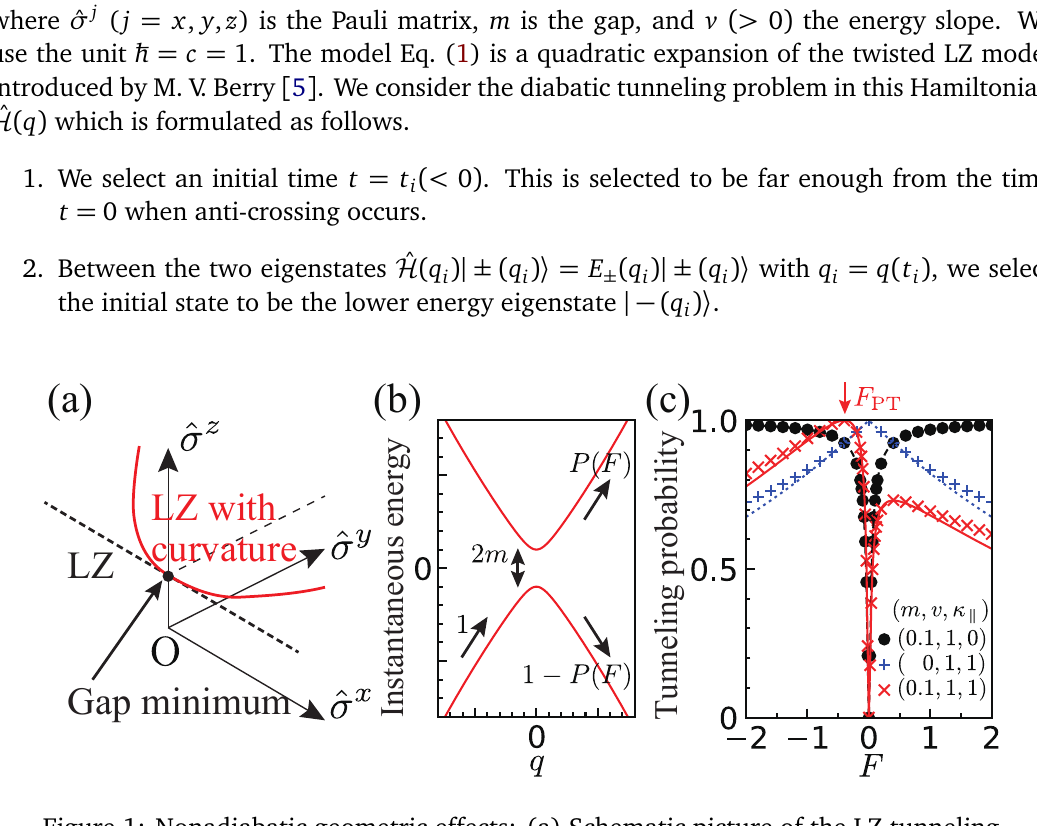
Figure 1: Nonadiabatic geometric effects: (a) Schematic picture of the LZ tunneling with curvature in parameter space. (b) Instantaneous energy of the Hamiltonian Eq. (1) with ( m , v , κ (cid:107) ) = ( 0.1,1,1 ) and schematic picture for quantum tunneling. (c) Tunneling probability P ( F ) for Eq. (1) with a parameter sweep q = − F t obtained numerically (marks) compared with the tunneling formula Eq. (2)